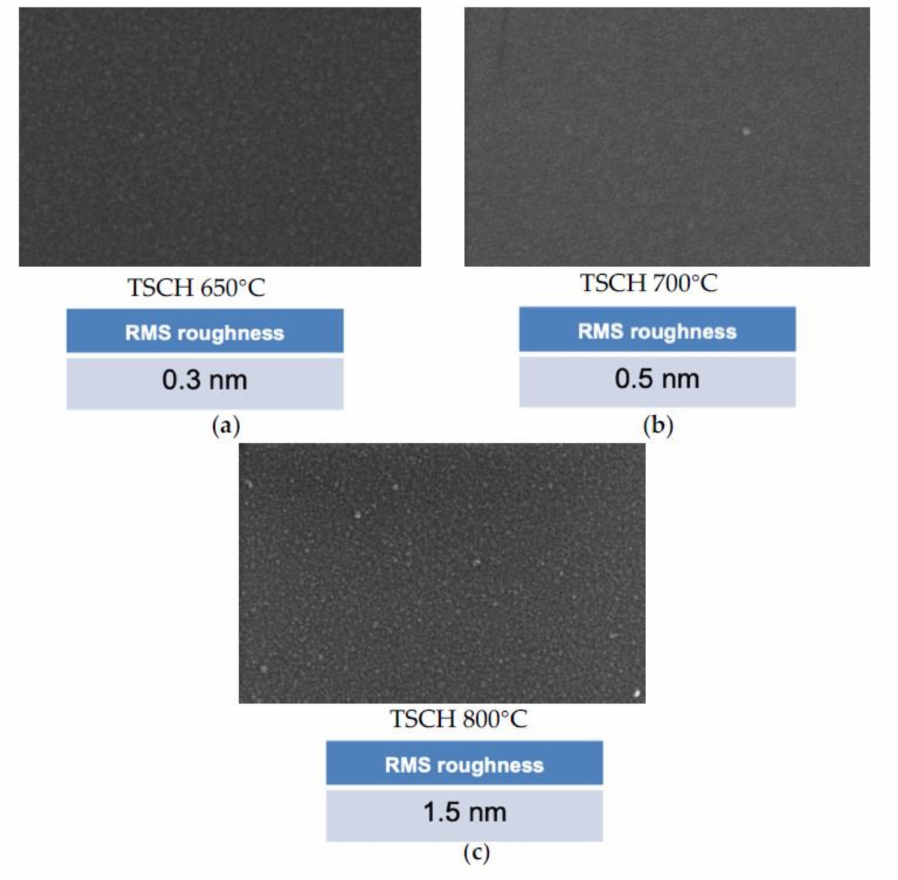
Figure 12. Scanning electron microscopy (SEM) micrographs for as-deposited SiC films grown from TSCH at: ( a ) 650 ◦ C, ( b ) 700 ◦ C, and ( c ) 800 ◦